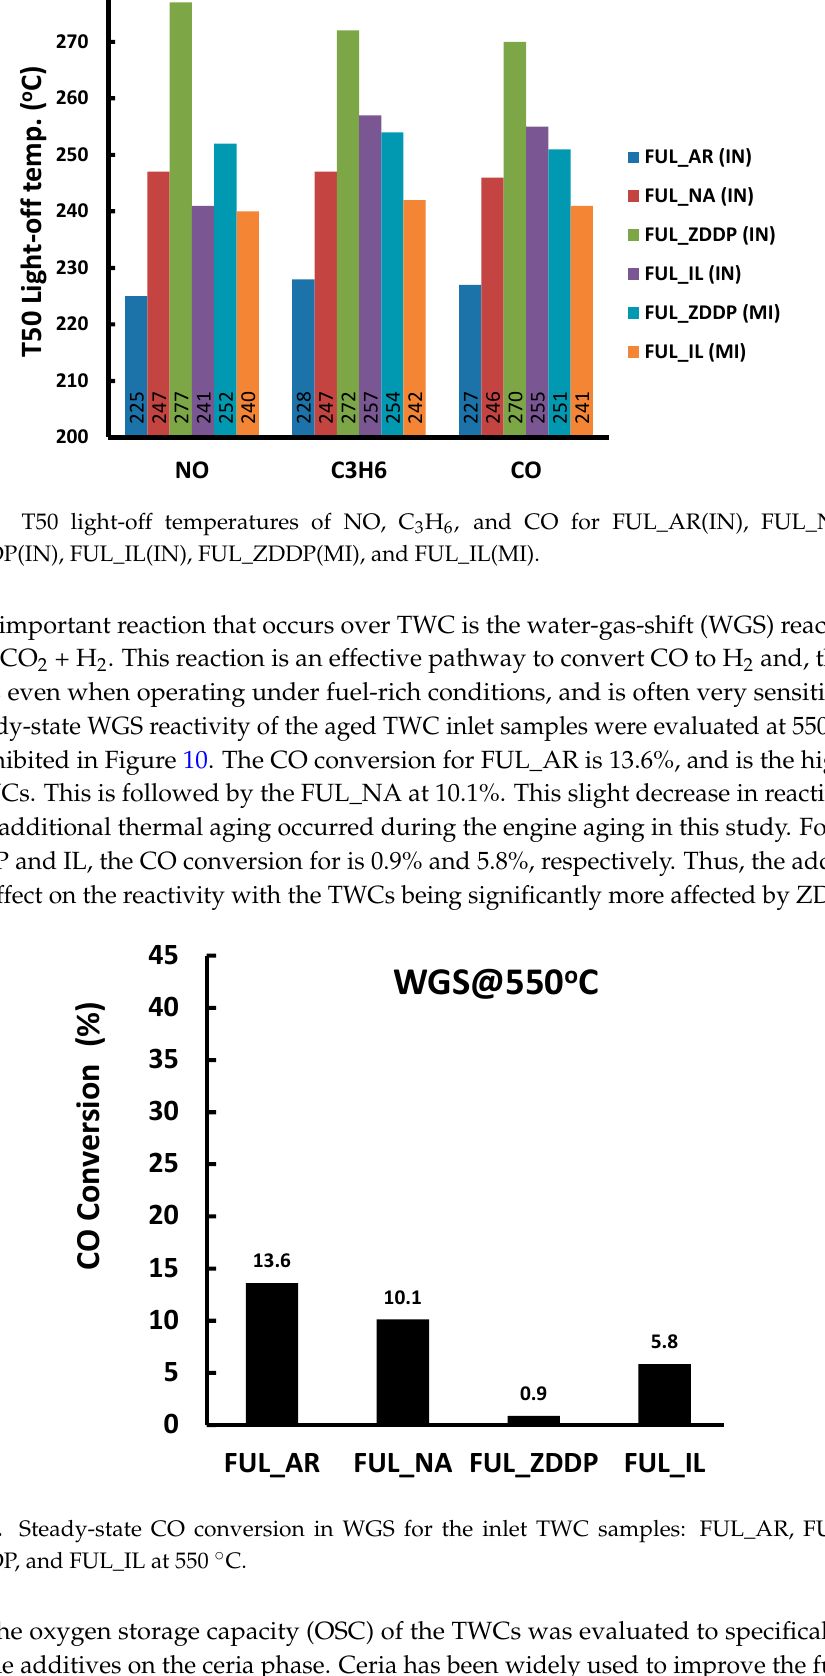
Figure 10. Steady ‐ state CO conversion in WGS for the inlet TWC samples: FUL_AR, FUL_NA, FUL_ZDDP, and FUL_IL at 550 °C.